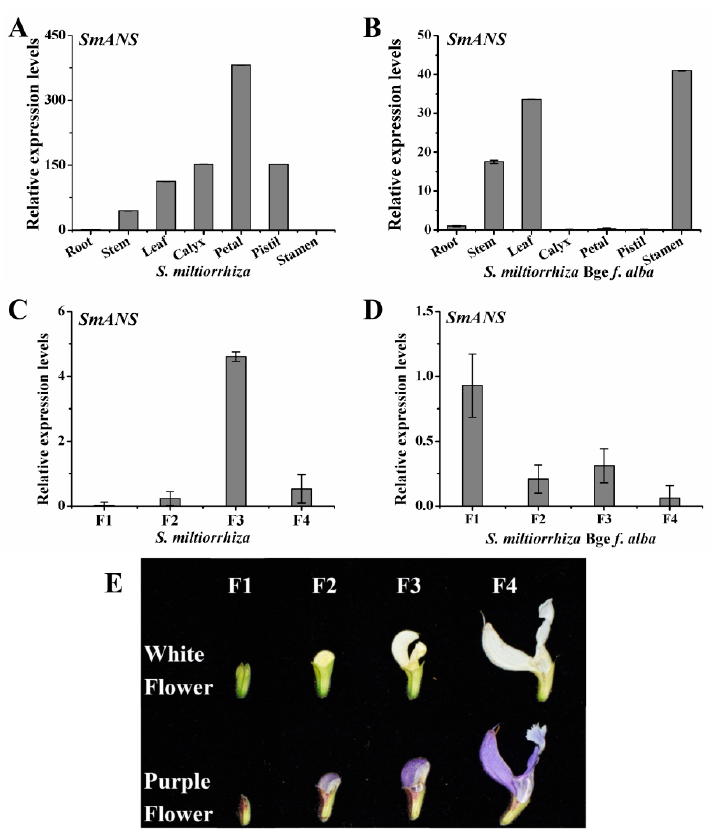
Figure 2. Spatial-temporal expression of SmANS in Salvia miltiorrhiza and S. miltiorrhiza Bge f. alba . ( A ) Relative expression levels of SmANS in various organs of S. miltiorrhiza ; ( B ) Relative expression levels of SmANS in various organs of S. miltiorrhiza Bge f. alba ; ( C , D ) Relative expression levels of SmANS in flowers of four flowering stages from S. miltiorrhiza and S. miltiorrhiza Bge f. alba , respectively; ( E ) The purple flowers S. miltiorrhiza and white flowers S. miltiorrhiza Bge f. alba of four flowering stages. F1, young-bud; F2, medium-bud; F3, pre-bloom petal; and F4, full-bloom petal. The vertical bars show the SD values from three independent biological replicates.